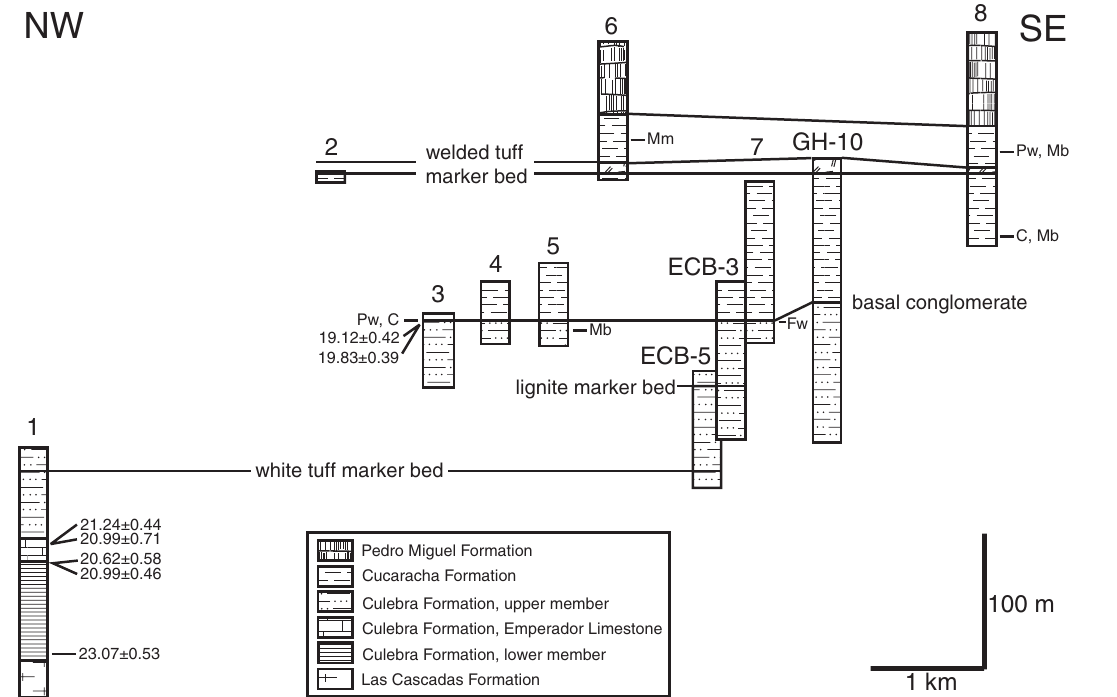
Figure 6. Lithostratigraphic correlation of stratigraphic sections 1 to 8 and drill cores logged by R. H. Stewart of the Panama Canal Company (ECB-5, ECB-3 and GH-10) arranged northwest to southeast along the Gaillard Cut portion of the Panama Canal. Location of stratigraphic sections and drill holes in Figure 3. Absolute ages (Ma) are derived from Sr chemostratigraphic analyses (see text). C=cf. Cynorca sp. Mm= Merycochoerus matthewi . Pw= Paratoceras wardi . Mb= Menoceras barbouri . Fw= Floridaceras whitei